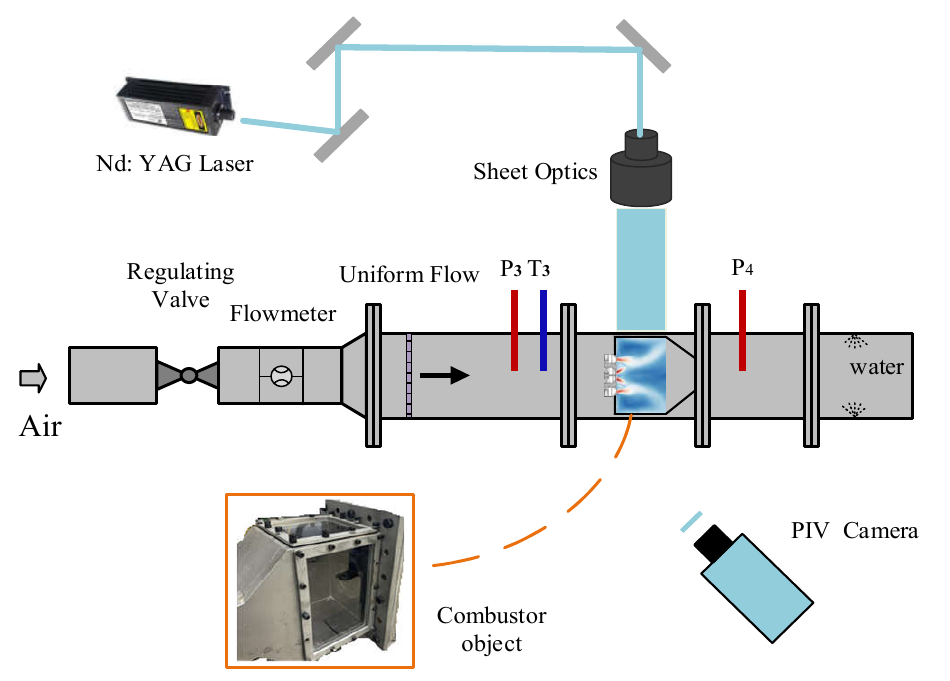
Figure 5. The PIV flow field measurement system.